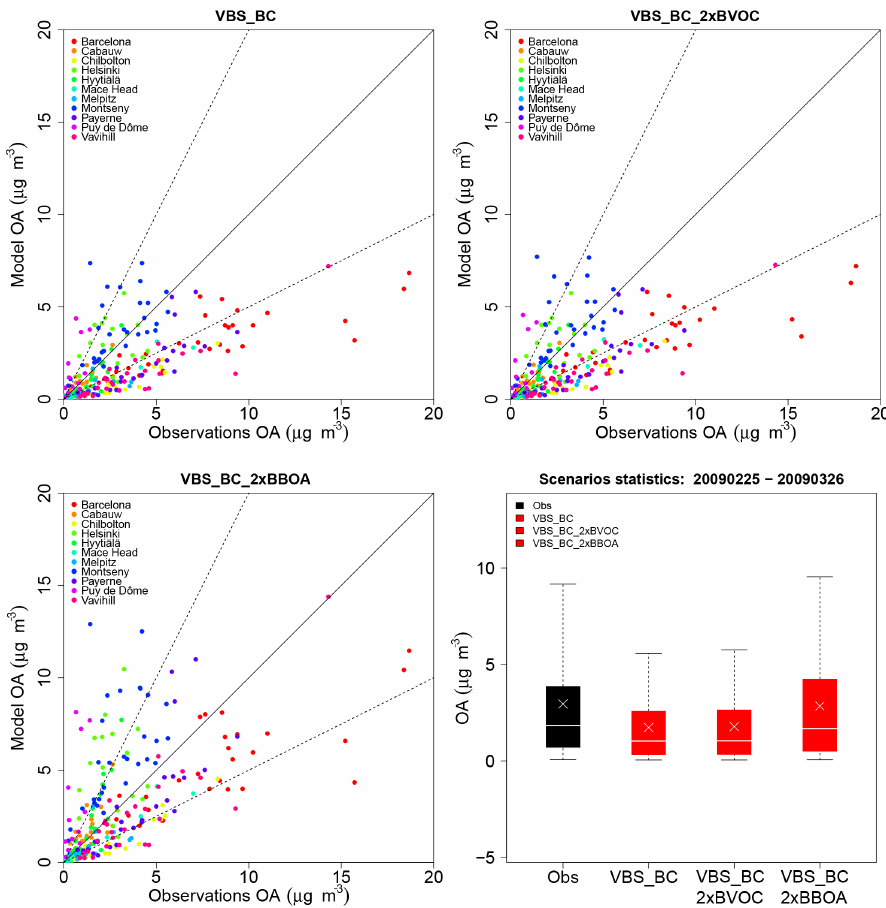
Figure 8. OA daily average scatter plots for VBS_BC, VBS_BC_2xBVOC and VBS_ BC_2xBBOA scenarios for February–March 2009 for stations in Table 3. Solid lines indicate the 1 : 1 line. Dotted lines are the 1 : 2 and 2 : 1 lines. Box plots indicate medians, 5th, 25th, 75th and 95th quantiles for observations (black) and sensitivity tests (red). The crosses represent the arithmetic